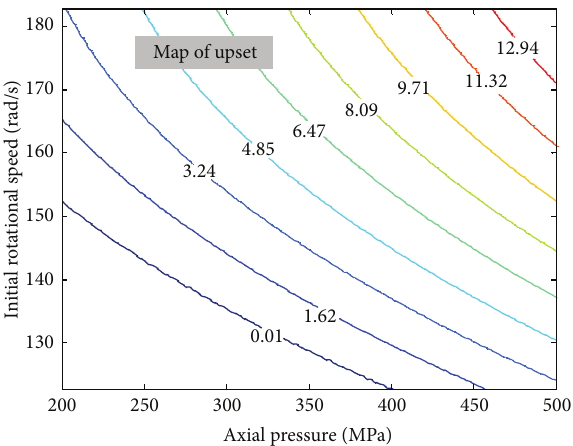
Figure 11: Scatter diagram of RBF prediction versus actual upset of LFW.